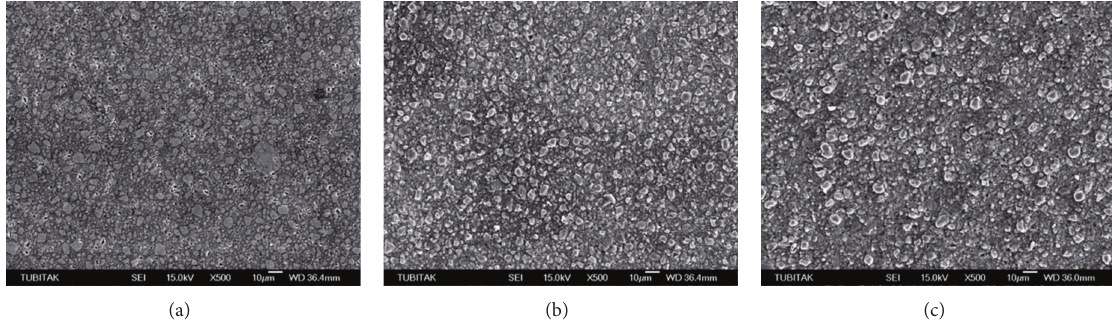
Figure 3: (a) Scanning electron micrograph of EST-C group showed a homogeneous surface with a dense filler distribution and debonding of some inorganic fillers. (b, c) EST-DT and EST-TP groups revealed resin removal between the fillers and debonding of small filler particles.